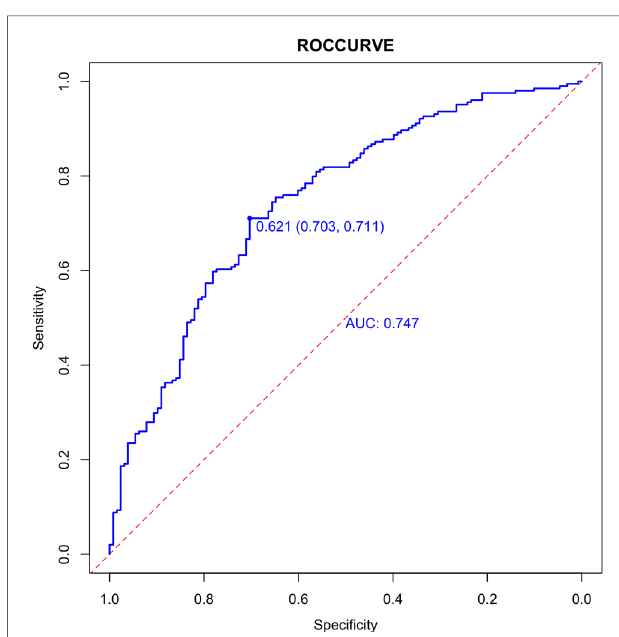
FIGURE 2 Internal validation of the column diagram: ROC. Of note: AUC: 0.747; 95% CI: 0.692-0.801; p